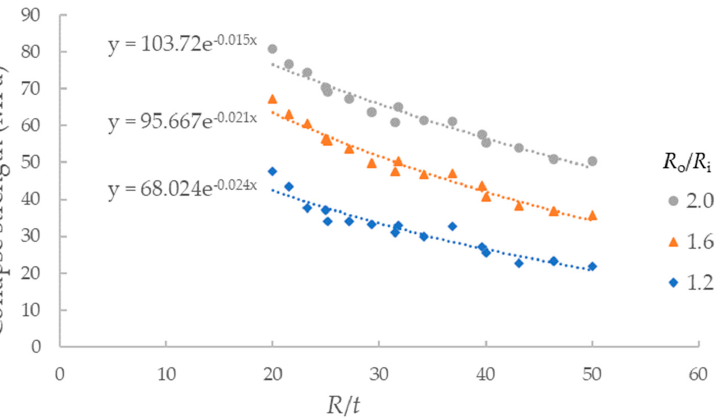
Figure 8. The relationship between collapse strength and parameter R / t ( λ / R o = 2.0, Δ = 0.2%).